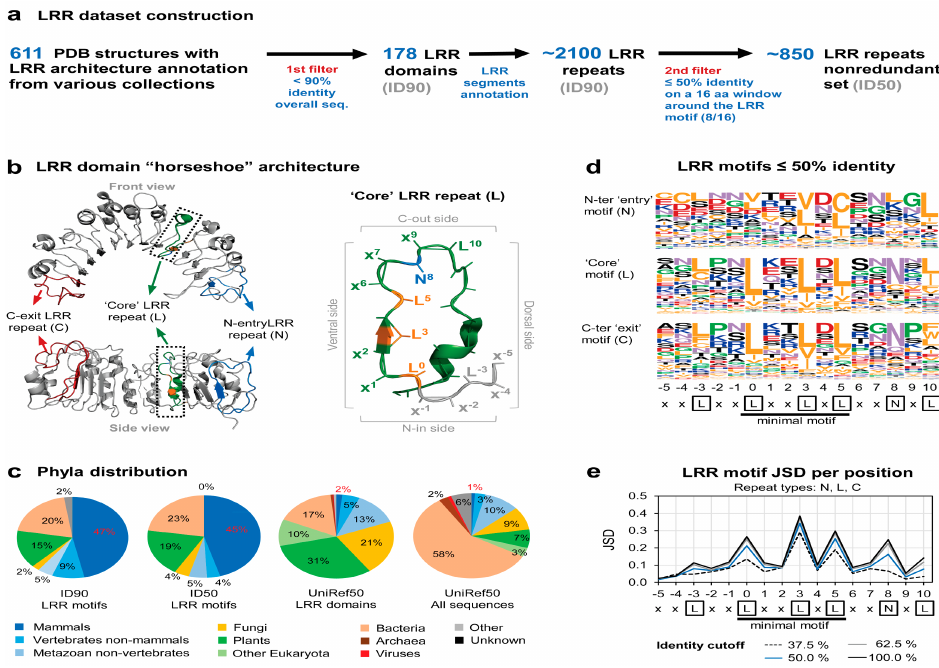
Figure 1. Available leucine-rich-repeat (LRR) domains in structural data. ( a ) LRR structural dataset construction. ( b ) LRR domain horseshoe architecture illustrated on the only plant NLR cryo-EM structure available—ZAR1—from Arabidopsis thaliana (left) and zoom-in view of a LRR repeat (right) (PDB: 6J5W). The hydrophobic positions in the minimal ‘L 0 xxL 3 xL 5 ’ motif are shown in orange. The first N-entry repeat (blue) and the last C-exit repeat (red) are also mapped on the structure. ( c ) Phyla distribution of the initial LRR motif set ID90, the 50% identity trimmed LRR motifs set (ID50), annotated LRR proteins and all proteins from the UniRef50 database (from left to right). Percent values corresponding to the mammals group are shown in red. ( d ) Frequency plot of amino acid composition of the N-entry, core and C-exit motifs on the 50% identity trimmed set. Amino acids are colored according to their properties as follows: hydrophobic (yellow), acidic (red), basic (blue), asparagine and glutamine (purple), proline and glycine (green), others (black). ( e ) Jensen–Shannon divergence (JSD) score for each position of the LRR motif at different identity thresholds. Higher values show increased conservation.